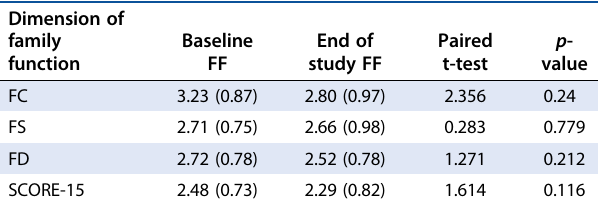
Table 3: Comparison of baseline and post-intervention mean family function scores of control group Dimension of family function